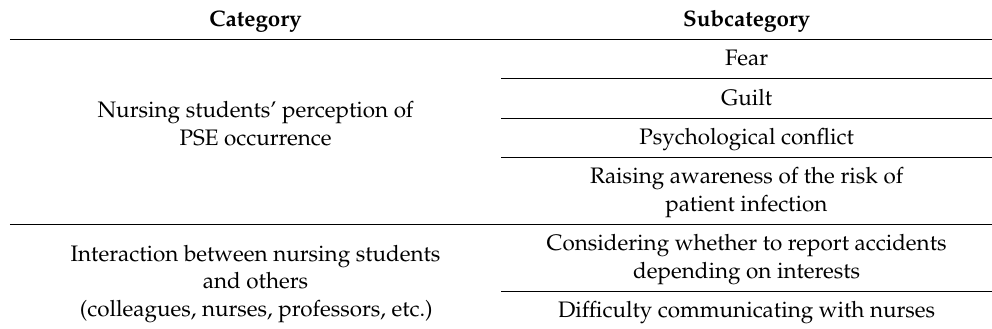
Table 2. Categories and subcategories about nursing students’ experience with patient safety